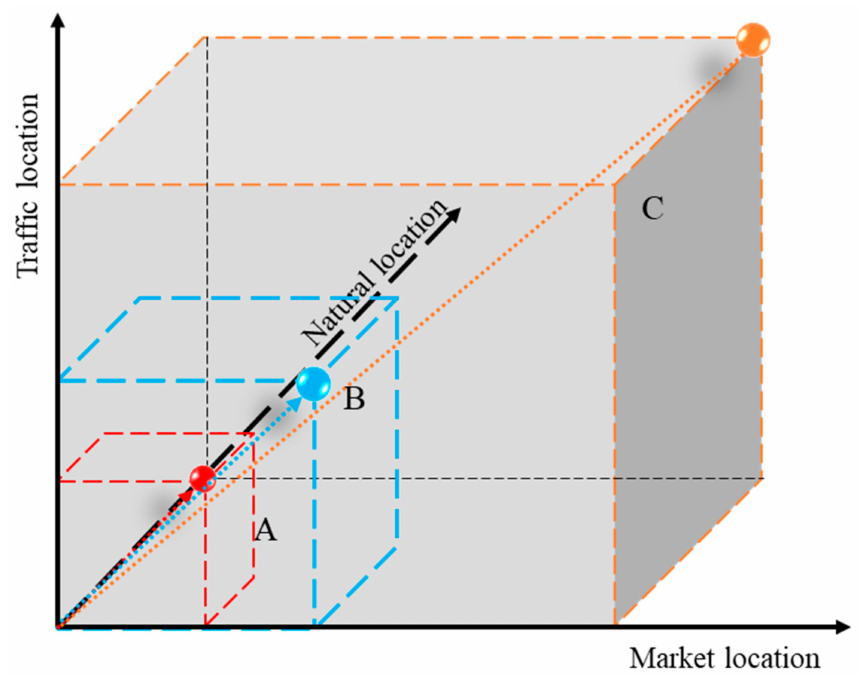
Figure 3. Point–axis–domain three-dimensional location